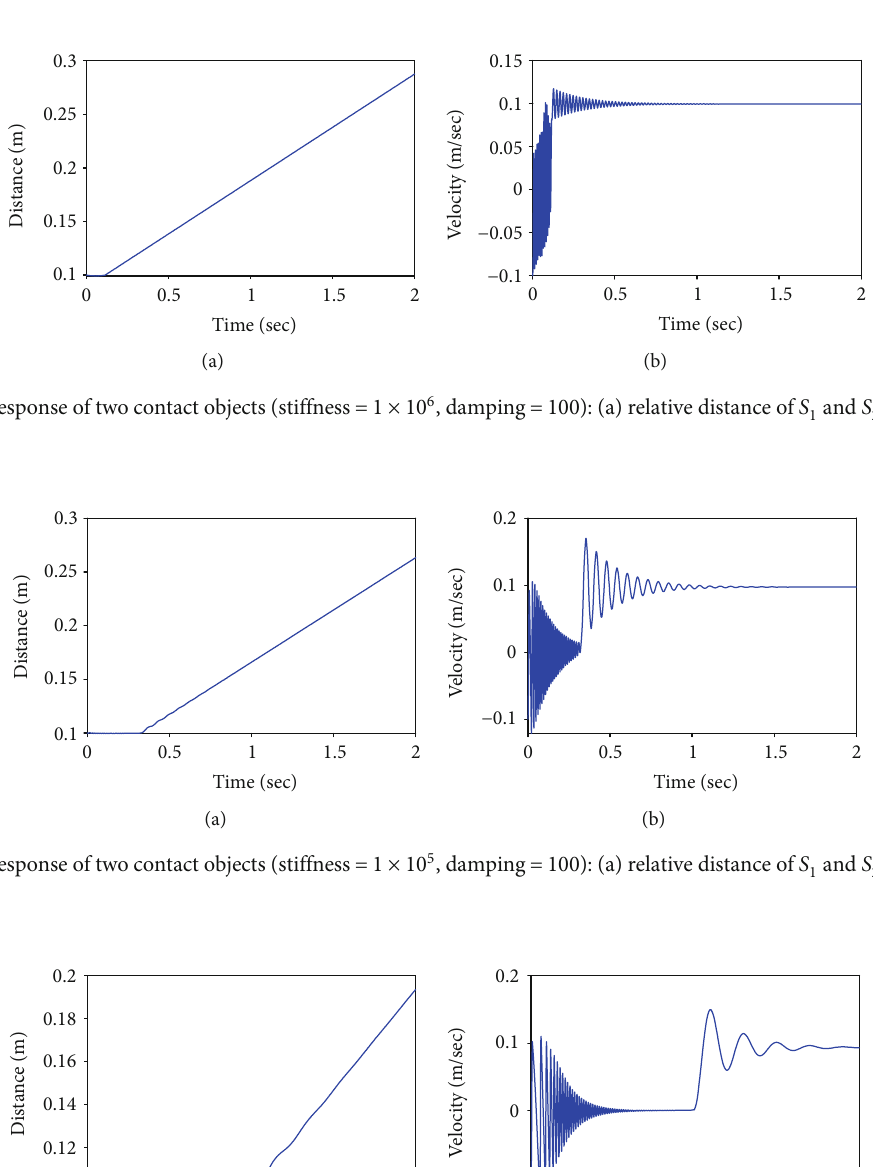
Figure 5: Dynamic response of two contact objects ( stiffness = 1 × 10 4 , damping = 10 ): (a) relative distance of S and S S 1 2 Figure 6 that the separation of S eral times of contact, and the change of the speed of S